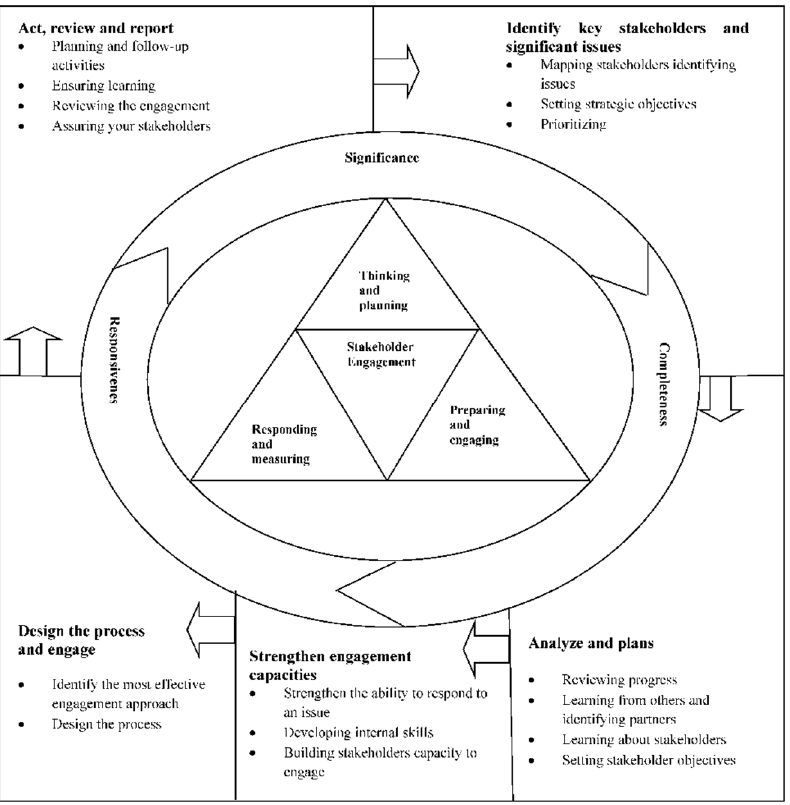
Figure 1. A process model of project stakeholder management (Bal et al. 2013). Table 1. The stakeholder management process (Huemann and Zuchi 2014, pp. 394–95,